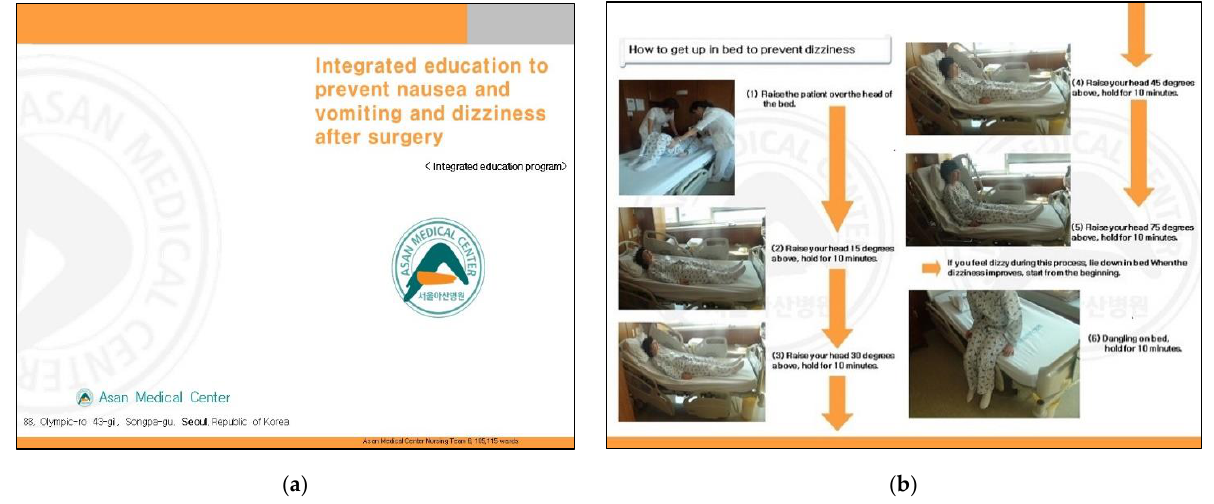
Figure 1. Anticipatory integrated education program brochure. ( a ) The cover of the educational program for nausea, vomiting, and dizziness prevention, and ( b ) photographs depicting the stepwise standing up method. Step 1, move the patient to the top part of the bed. Step 2, raise the bed by 15 ° and maintain that position until dizziness disappears. Steps 3 to 5, raise the bed by 30 ° , 45 ° , and 75 ° and maintain the position for 10 minutes each until dizziness disappears. In the last step, induce the return of venous blood by moving the patient’s legs while he or she sits on the bed. If no dizziness is felt, carry out early ambulation by standing up with a caregiver. If dizziness occurs during early ambulation, lie down on the bed. If dizziness disappears, try to stand up step-by-step from the start again. Reproduced with permission from EES, YHS, HJP, ESL.